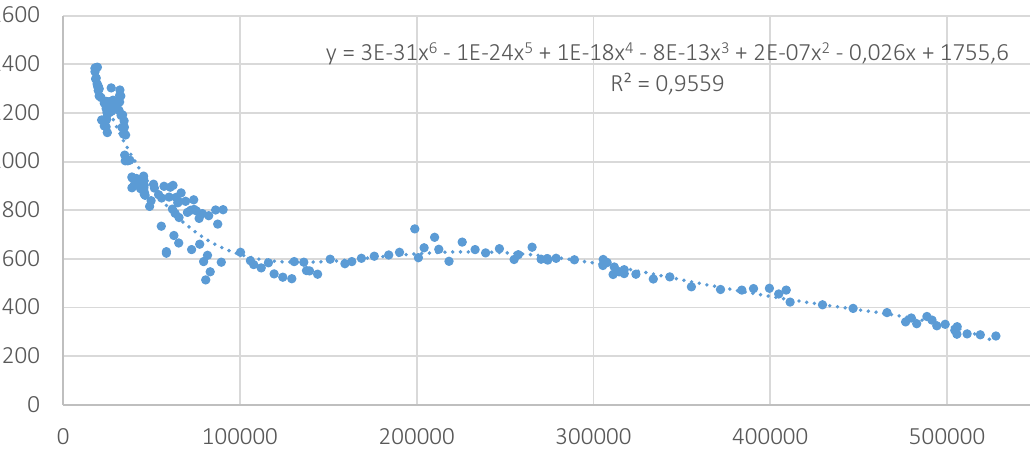
Figure 4. Energy intensity in Gigajoule derived units vs GDP per capita in 2015-NOK, 1835–2019